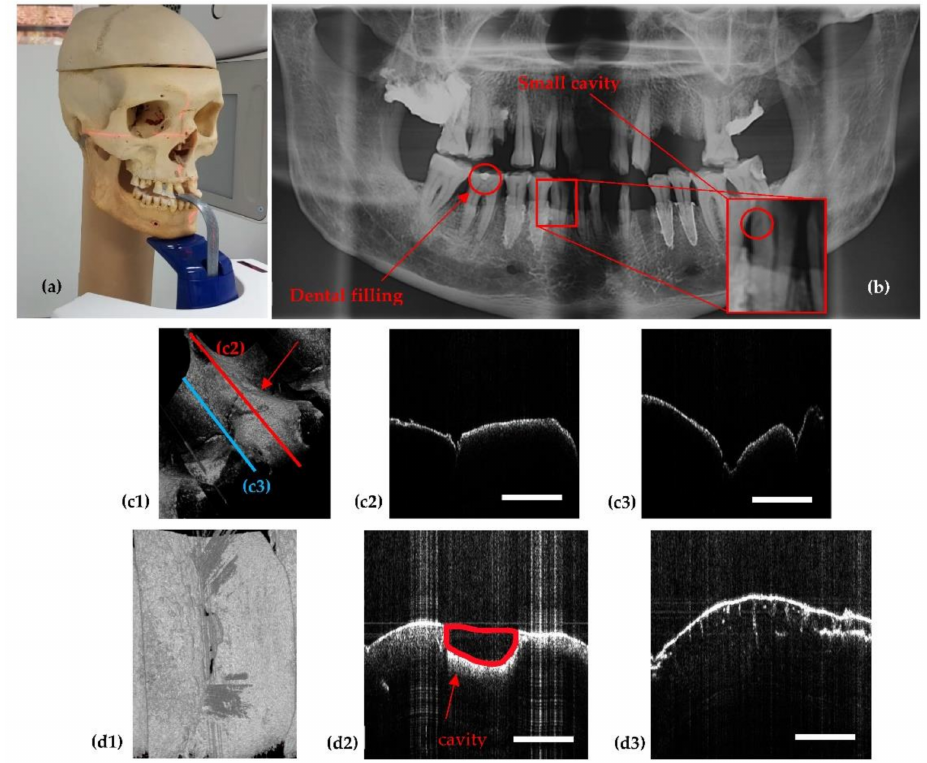
Figure 7. ( a ) The didactic human head used in the calibration process. ( b ) Panoramic radiograph illustrating the teeth that were further investigated with OCT. ( c1 ) OCT volumetric reconstruction of the tooth with a small dental filling, marked in (b); ( c2 ) B-scan/cross section corresponding to the position of the red line placed on the 3D view of the tooth in (c1); ( c3 ) B-scan related to the blue line position in (c1). ( d1 ) OCT volumetric reconstruction of a tooth that has a small cavity barely visible on the panoramic radiograph in (b); ( d2 ) B-scan showing the cavity in (b); ( d3 ) B-scan showing an additional condition of the tooth, i.e., demineralization (observed from the small cracks in the dentine). Scale: 1